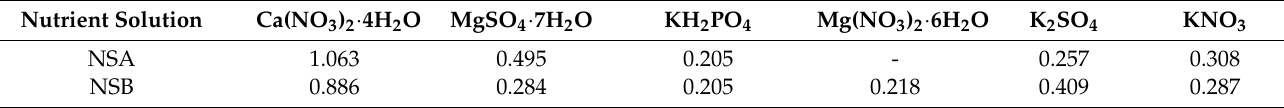
Table 3. Sources of macronutrients used in the NSA and NSB nutrient solutions (g L − 1 ). Nutrient